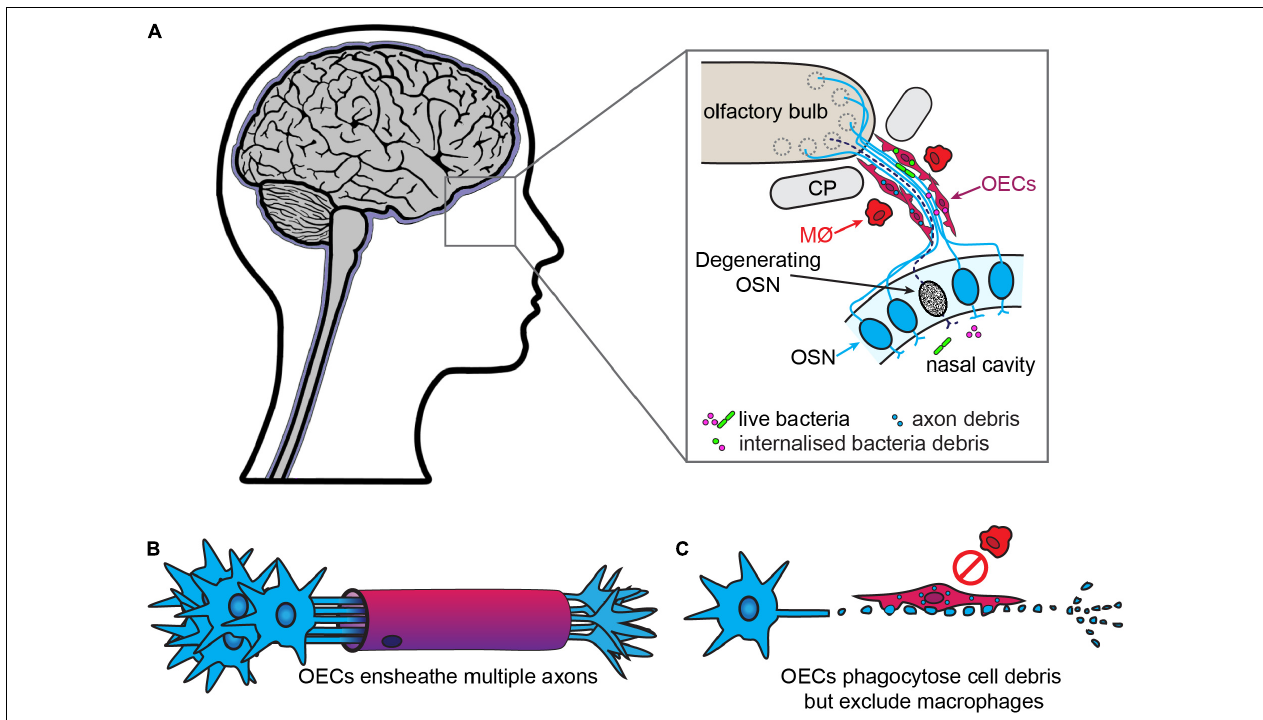
FIGURE 2 | Olfactory ensheathing cells are the primary phagocytes in the olfactory nerve. (A) In the olfactory system, olfactory sensory neurons (OSN, blue) project dendrites into the nasal cavity and extend axons into the olfactory bulb. The bundles of olfactory axons are surrounded by OECs. OSNs are constantly turned over and replaced, with the debris from the degenerating axons (dashed line) phagocytosed by OECs. The OECs also provide a line of defense against bacteria from the nasal cavity which penetrate the olfactory nerve, with OECs engulfing the bacteria. Macrophages (MØ) are largely absent from the olfactory nerve. (B) In contrast to SCs, OECs ensheathe multiple axons and do not myelinate olfactory axons. (C) After injury, OECs phagocytose cell debris but do not recruit